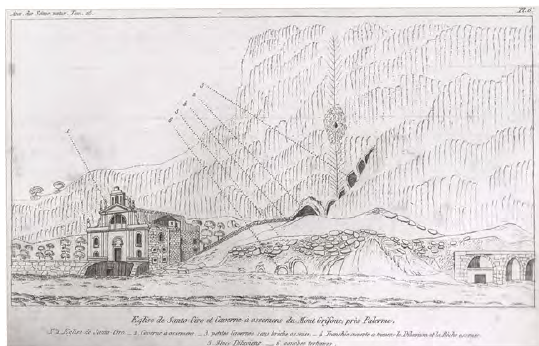
Figure 4. Reconstruction of the monumental system underGrifone mountain: the church of Saint Ciro, the Arcs and the caverns with restsfrom Neolithic era (Turnbull,